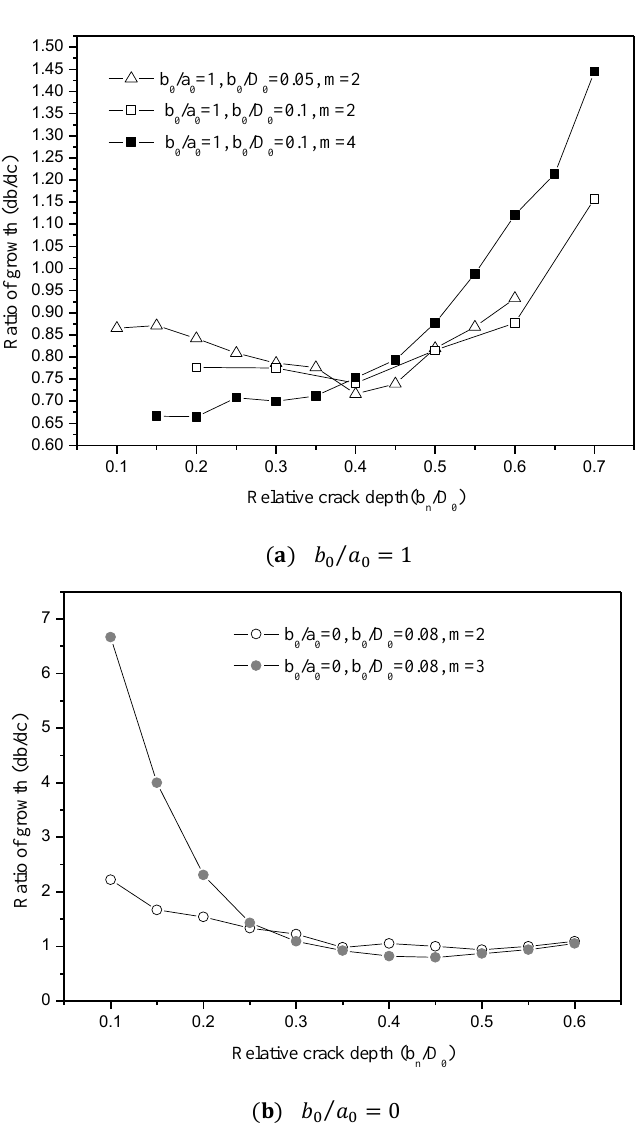
Figure 11. Ratio of crack growth along the vertical central line and toward the horizontal surface.